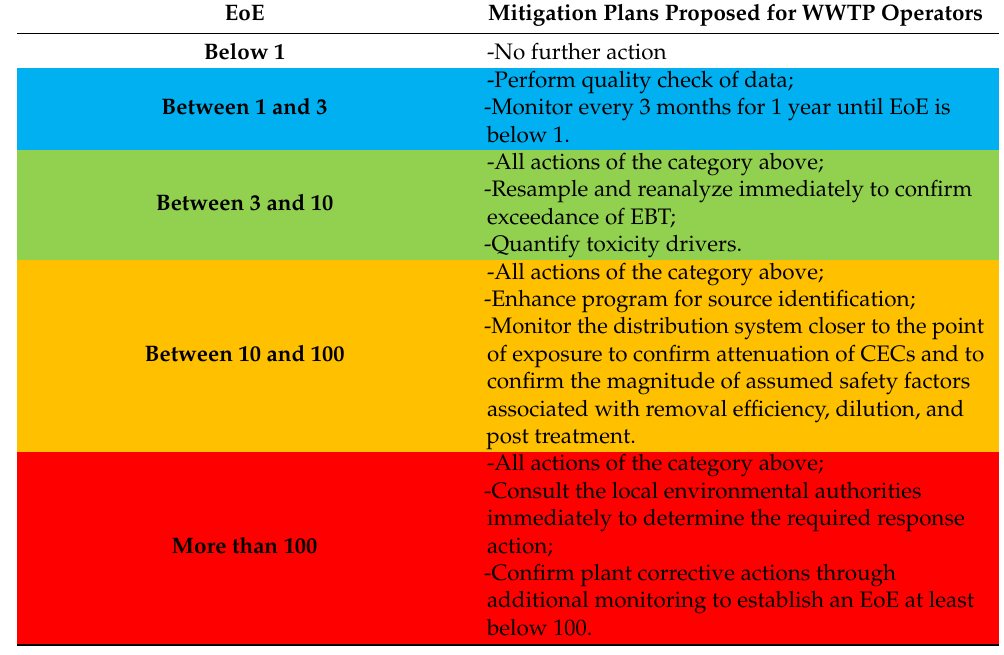
Table 2. Proposed actions in case of exceedance of